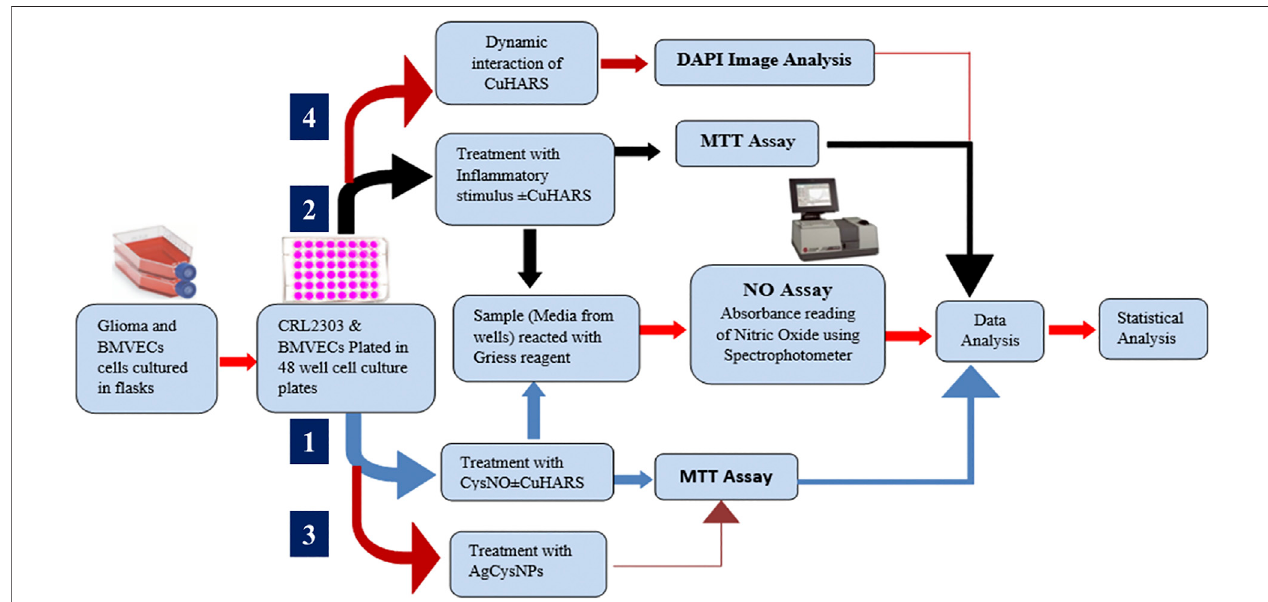
SCHEME 1 | Schematics showing the overall experimental layout of the project illustrating the pathways for cell treatment with CuHARS in presence of CysNO (Darder et al., 2020) and in the presence of in fl ammatory stimulus, dynamic interaction of CuHARS with cells, and for treatment of cells using AgCysNPs.